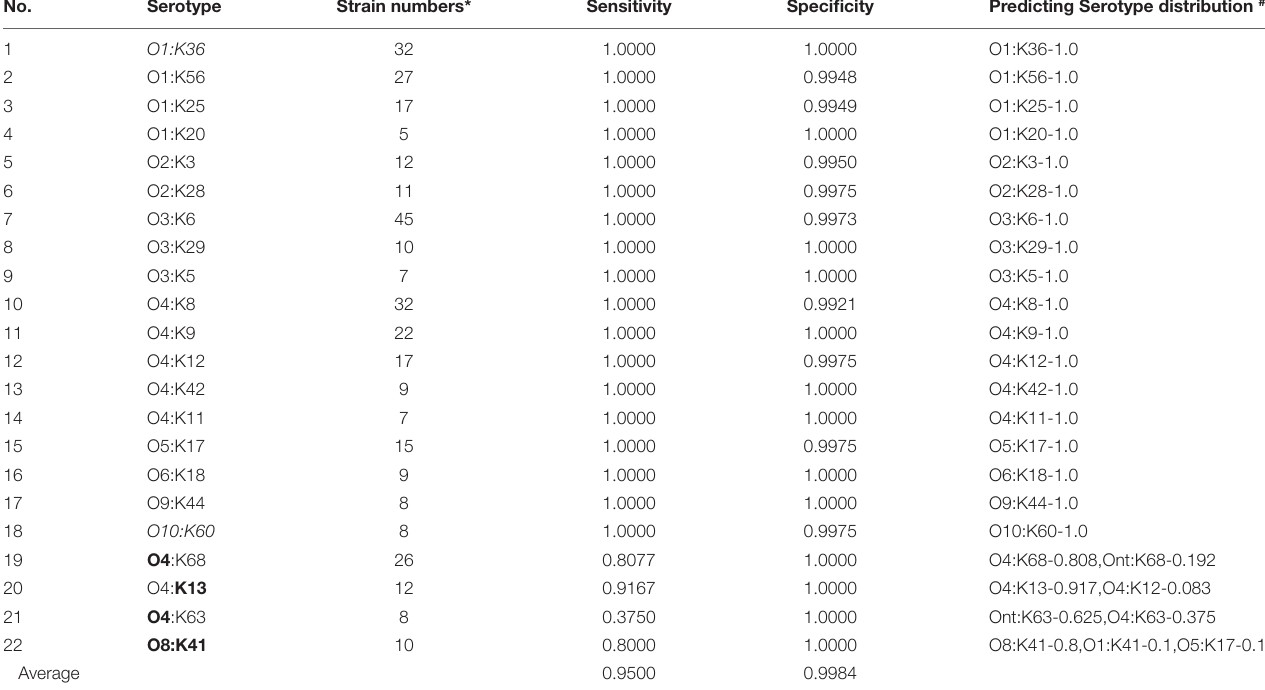
TABLE 3 | Sensitivity and specificity for 21 serotypes identification using VPsero. No. Serotype Strain numbers* Sensitivity Specificity Predicting Serotype distribution